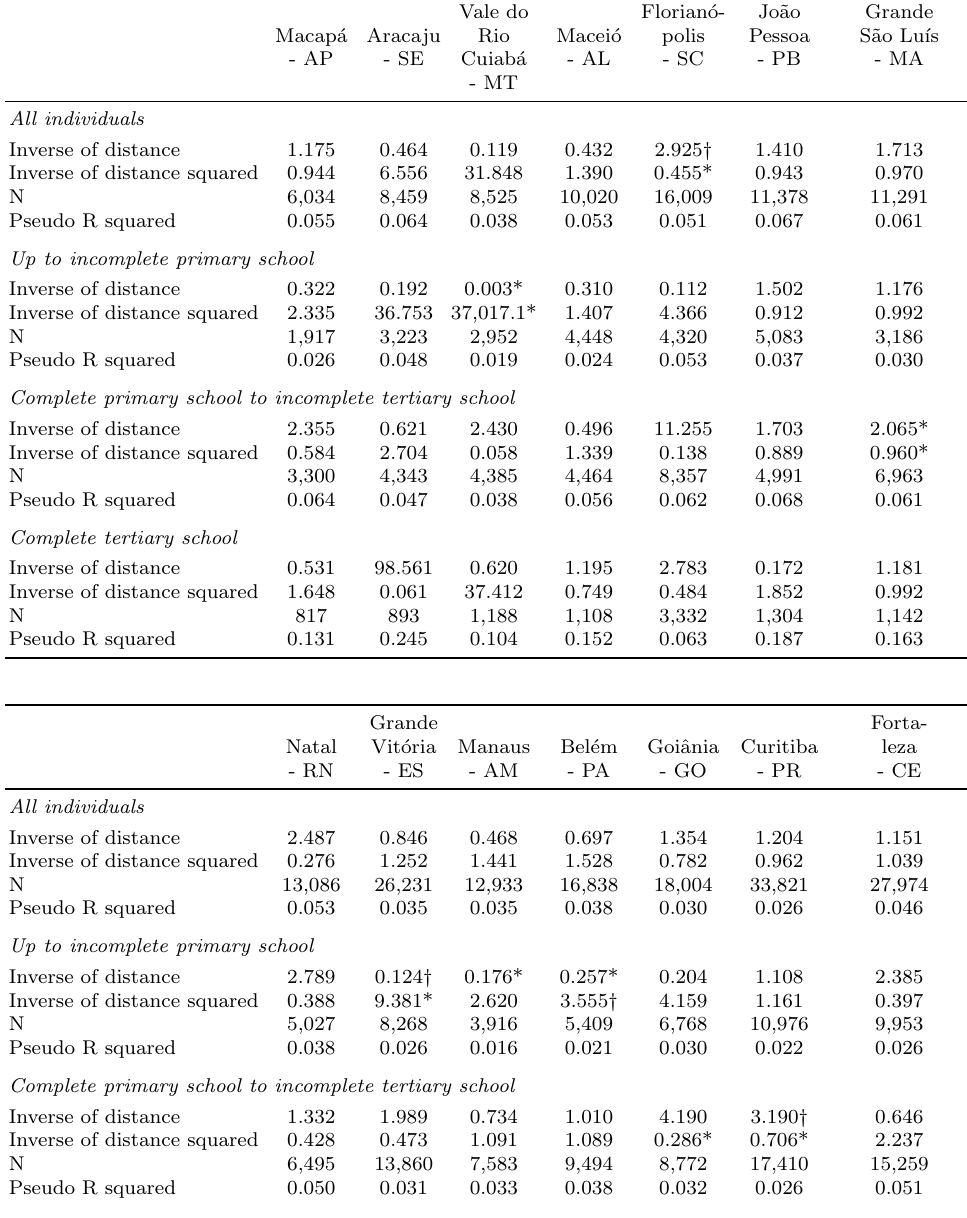
Table 6: Logit model for the probability of being unemployed, regressions with all individuals and by education